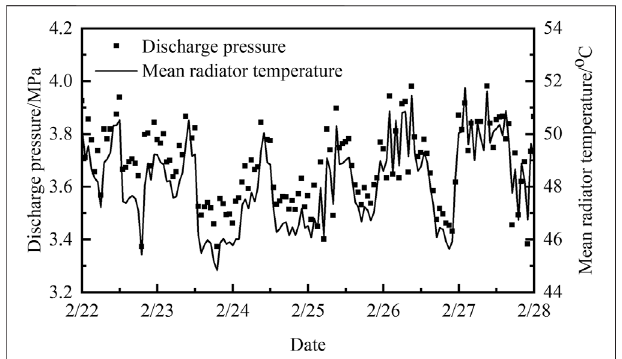
FIGURE 8 | Hourly discharge pressure during the test